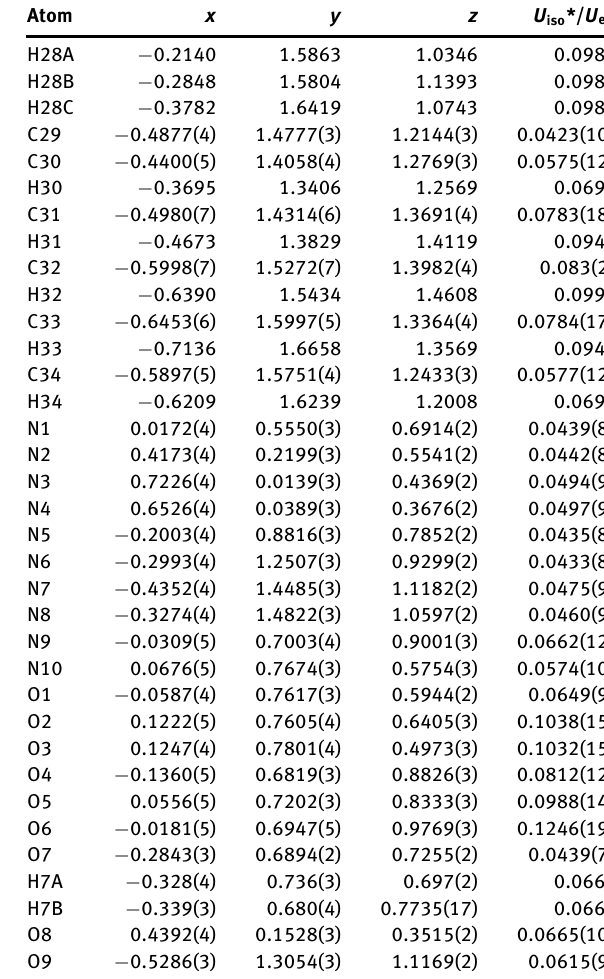
Table 2: Fractional atomic coordinates and isotropic or equivalent isotropic displacement parameters (Å 2